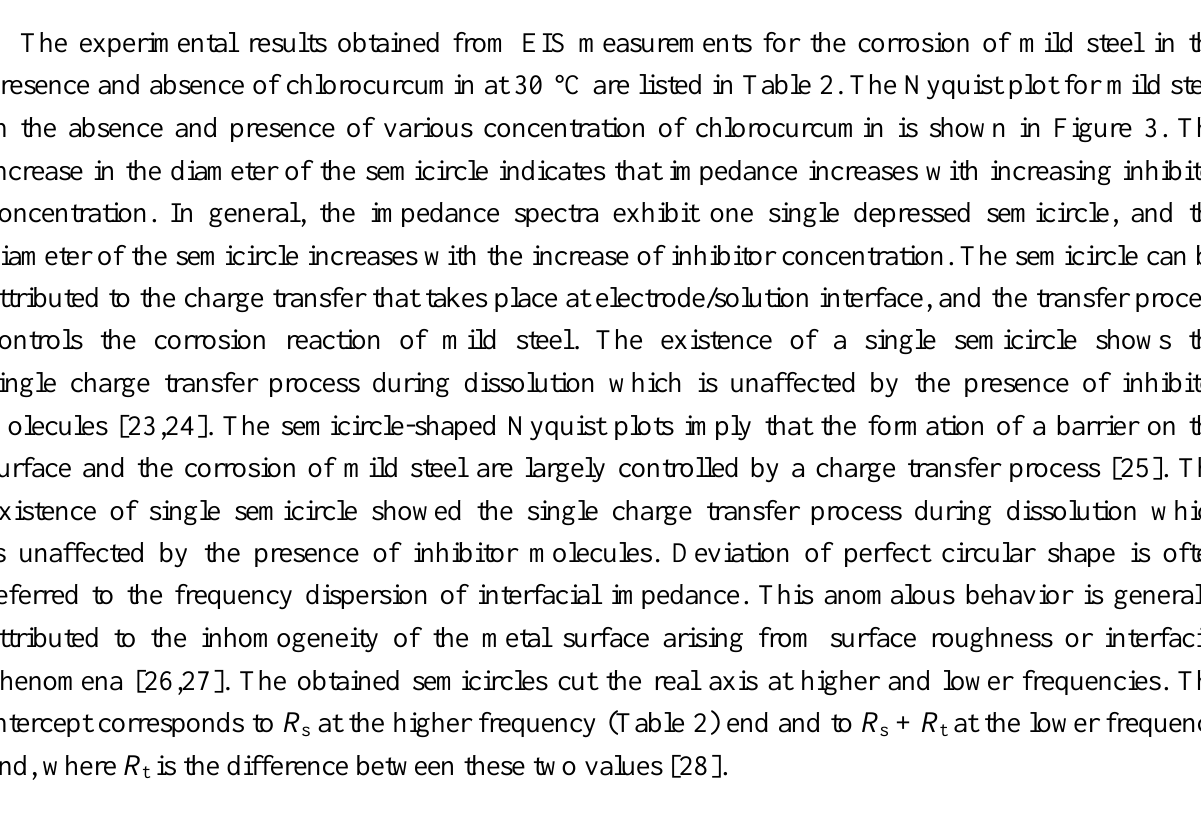
Table 2. Impedance parameters for mild steel in 1.0 M HCl with different concentrations of chlorocurcumin at 30